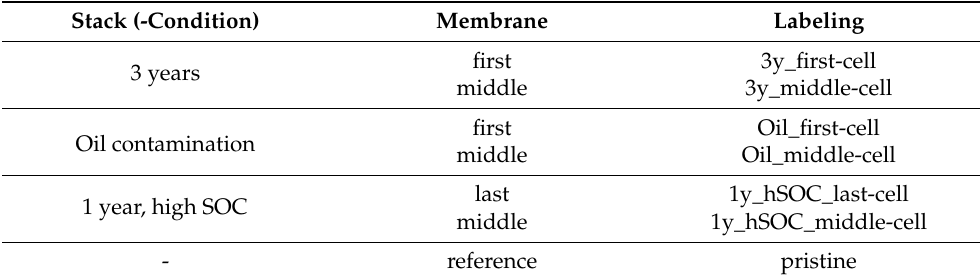
Table 1. FAP 450 membranes, retrieved from decommissioned stacks of real battery systems. Stack (-Condition) Membrane Labeling first 3y_first-cell 3 years middle 3y_middle-cell first Oil_first-cell Oil contamination middle Oil_middle-cell last 1y_hSOC_last-cell 1 year, high SOC middle 1y_hSOC_middle-cell - reference